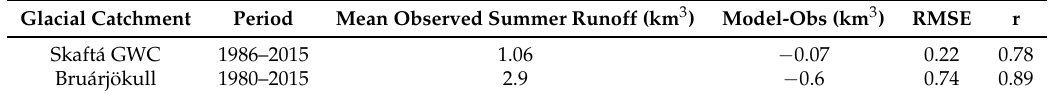
Figure 5. Total summer runoff (April–October) from Skaftá GWC (blue points) into Skaftá river and Brúarjökull (red points) into Jökulsá á Dal river at Hjarðarhagi (1980–2007) and Hálslón reservoir (2007–2015) compared to the modeled value. Table 2. Comparison statistics of the average summer runoff (April–October) from Skaftá GWC into Skaftá river and from Brúarjökull into Jökulsá á Dal river at Hjarðarhagi (1980–2007) and Hálslón reservoir (2007–2015) according to observations and the simulation. The mean difference, RMSE, and correlation are